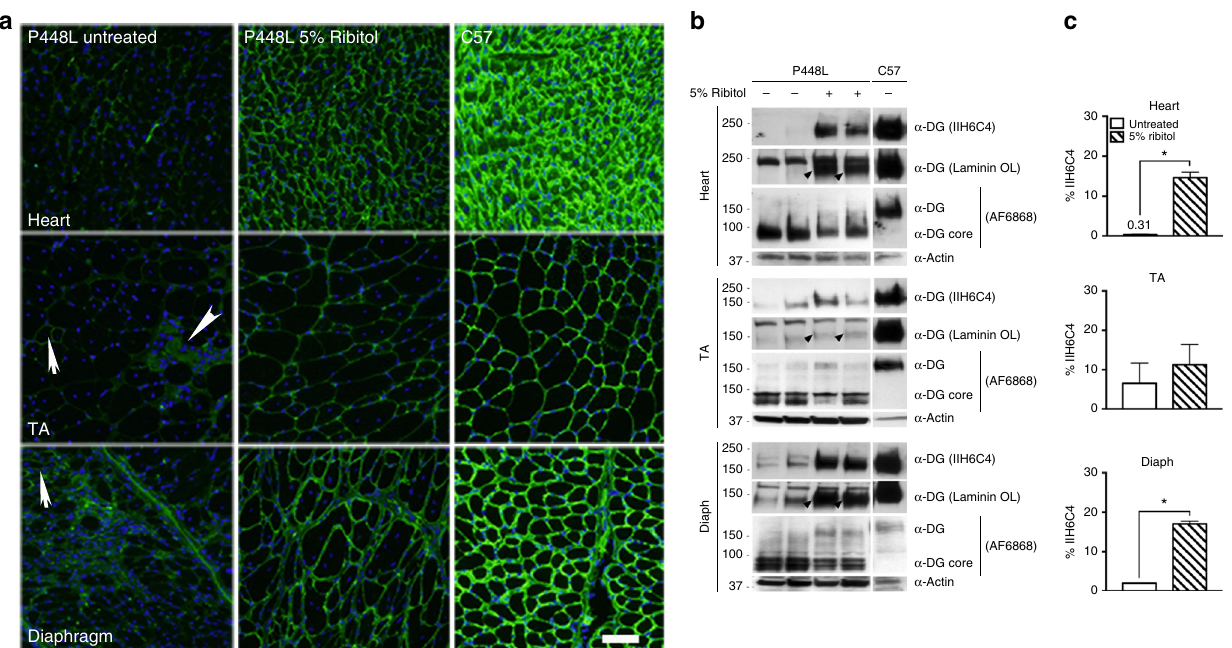
Fig. 3 Induction of F- α -DG in cardiac and skeletal muscles of P448L mice treated with ribitol for 6 months. Seven-week-old P448L mice were given drinking water only ( n = 4), or drinking water supplemented with 5% ribitol ( n = 4). a IIH6C4 immunohistochemical staining of cardiac (heart), tibialis anterior (TA), and diaphragm tissues from either untreated or 5% ribitol-treated P448L mice (left and middle panel, respectively), and C57 mice. Nuclei were counterstained with DAPI (blue). Arrows indicate the revertant fi bers expressing F- α -DG. Arrowhead indicates the degenerating fi bers and focal accumulation of nuclei. Scale bar, 50 μ m. b Western blot and laminin overlay assay of lysates from heart, TA, and diaphragm (diaph) of two untreated ( − ) or two ribitol-treated ( + ) P448L , and C57 mice. F- α -DG was detected by blotting with IIH6C4 and by laminin overlay assay (Laminin OL). Core of α -DG was detected by AF6868 antibody with weaker signals for the ribitol-treated samples. Detection of α -actin was used as a loading control. Arrowheads indicate laminin-binding bands. The upper band with laminin-binding assay are endogenous laminin present in all samples. c Quanti fi cation of IIH6C4 band intensity from western blot. Values were normalized to α -actin expression for each tissue and presented as percentage of C57 levels. Error bars represent mean ± SEM. Unpaired t test. * p ≤